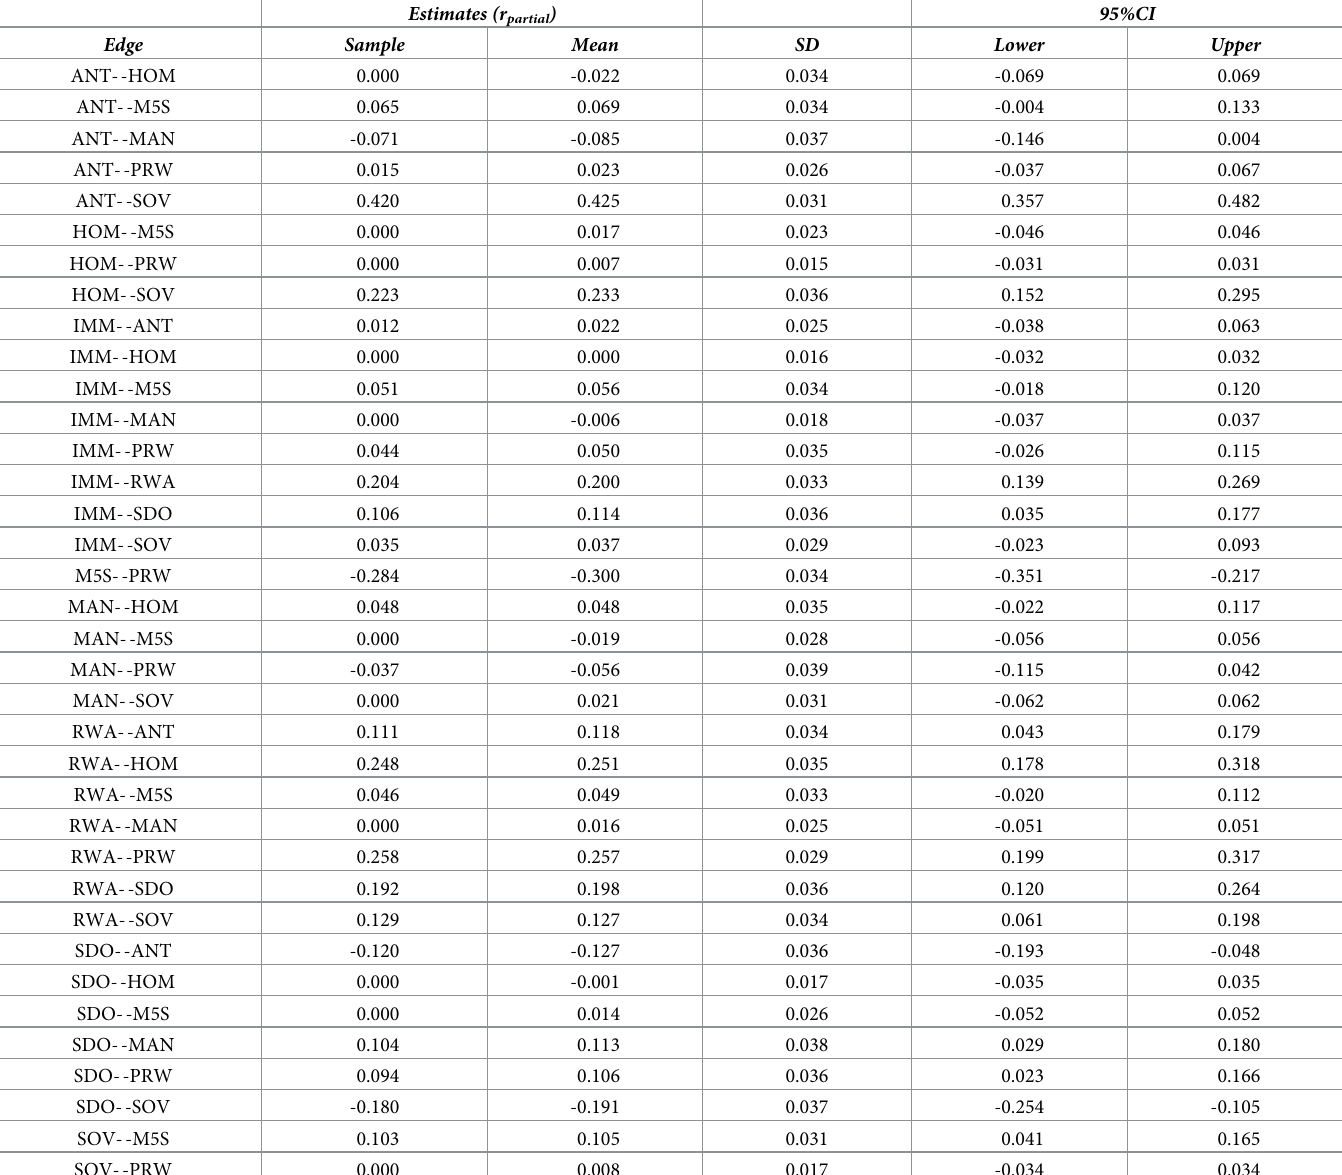
Table 6. Sample and bootstrap mean of edge-weights of the integrated beliefs system network including ideological attitudes, anti-immigration attitudes, populist ideology and